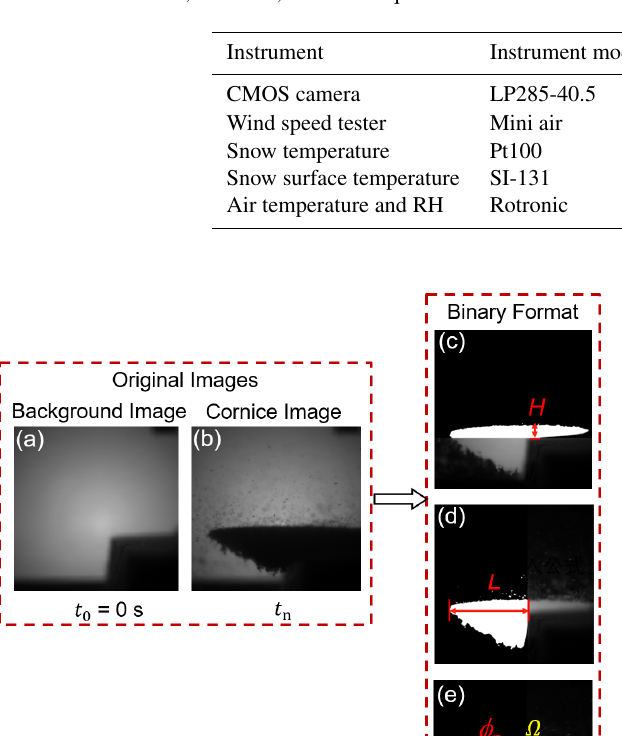
Table 1. Instruments, variables, and data acquisition interval.